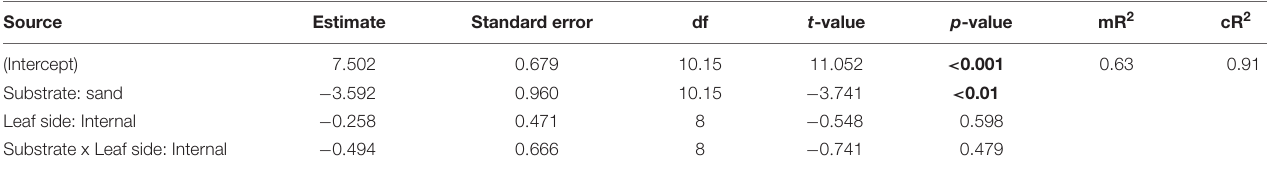
TABLE 2 | Mixed-effect model results of the effect of substrate type (two levels, rock and sand) and leaf side (two levels, internal and external) on total leaf epiphyte cover (expressed in percentage) on five-year old seedlings of Posidonia oceanica .